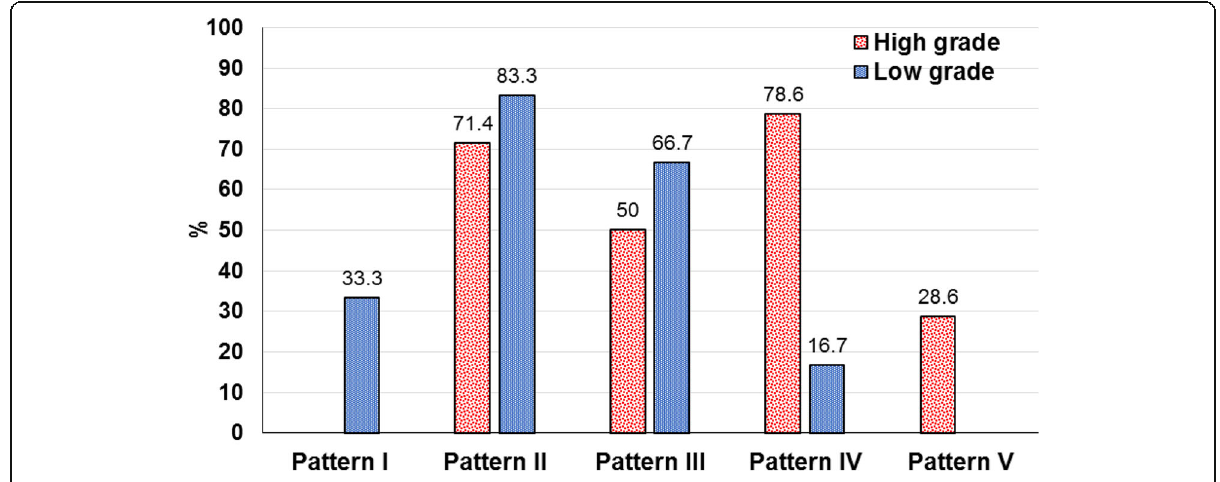
Fig. 8 Pattern of brain tumors on imaging